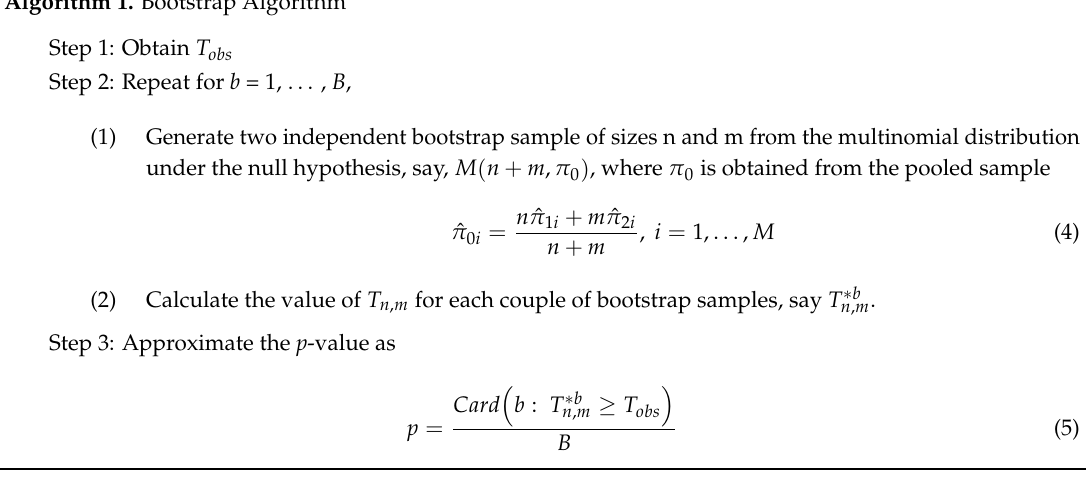
Algorithm 1. Bootstrap